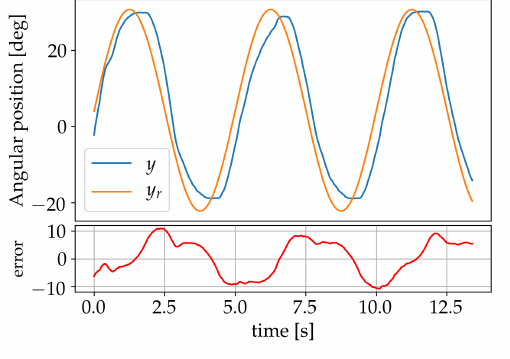
Figure 17. Result for a 0.05 Hz sine wave.